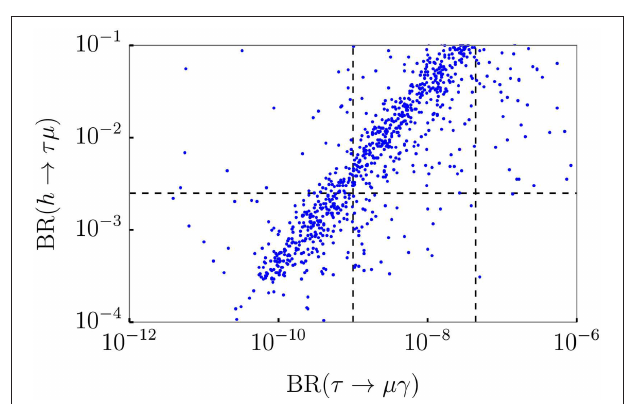
τµ ) as a function of BR( τ µγ ) in the type-III 2HDM. FIGURE 3 | BR( h → → The parameters are fixed as explained in the text. The vertical lines correspond µγ ) < 4.4 to the current bound BR( τ 10 − 8 [98] and the expected Belle-II → × sensitivity, estimated to be 10 − 9 [ 99]. Finally, the horizontal line indicates the ∼ τµ ) < 0.0025 limit by the CMS collaboration BR( h →